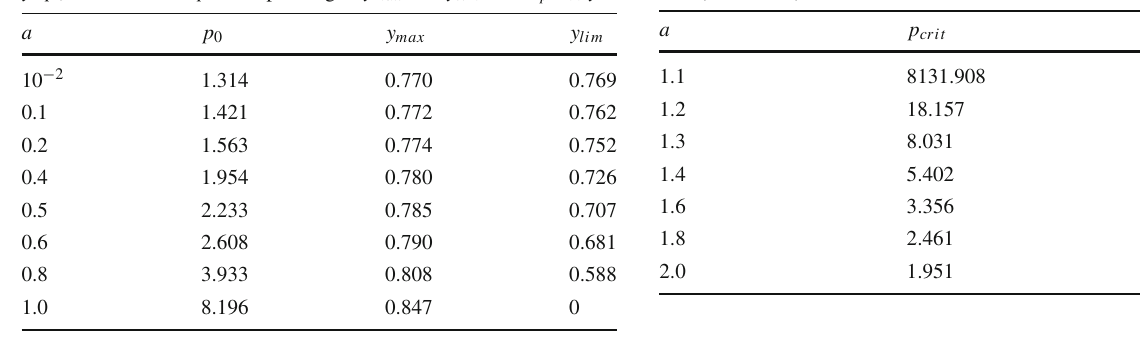
Table 1 Maximum and limiting values of y for various values of the model parameter a in the ground state n = 0 . y max is the maximum of y , p 0 is the value of p corresponding to y max and y lim = lim p →∞ y